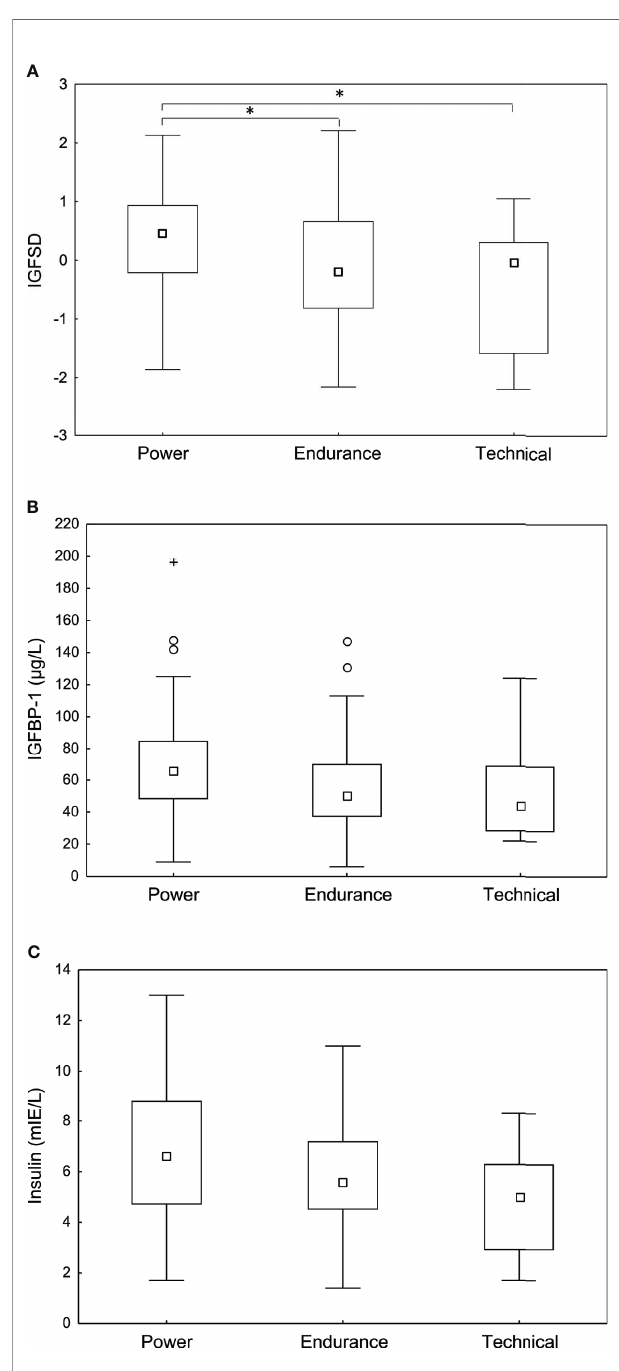
FIGURE 2 | Fasting (A) age adjusted insulin-like growth factor-I (IGFSD), (B) IGF-I binding protein-1 (IGFBP-1) and (C) insulin levels in power, endurance and technical athletes. Power athletes demonstrated signi fi cantly higher IGFSD compared to endurance and technical athletes. No signi fi cant difference in IGFBP-1 or insulin levels were observed between sport categories. Box plots showing median, Q25-75, total range, outliers and extremes. *p <